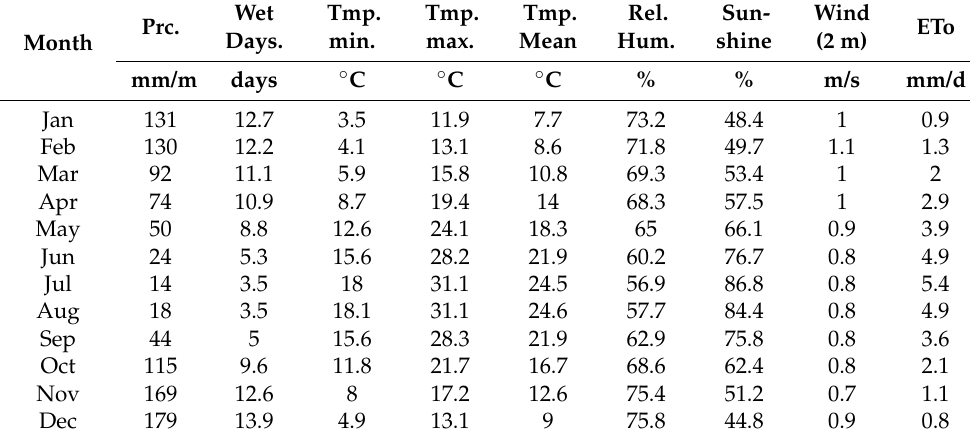
Table 1. Climate data for the study